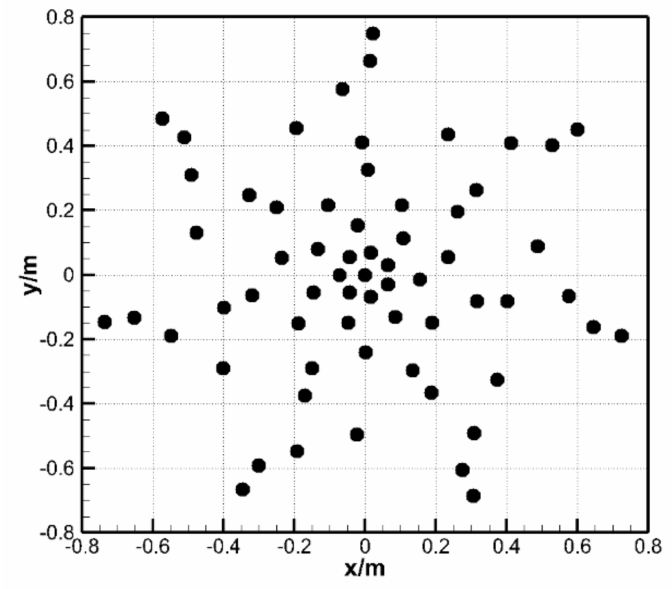
Figure 1. Layout of the planar array with sixty-four